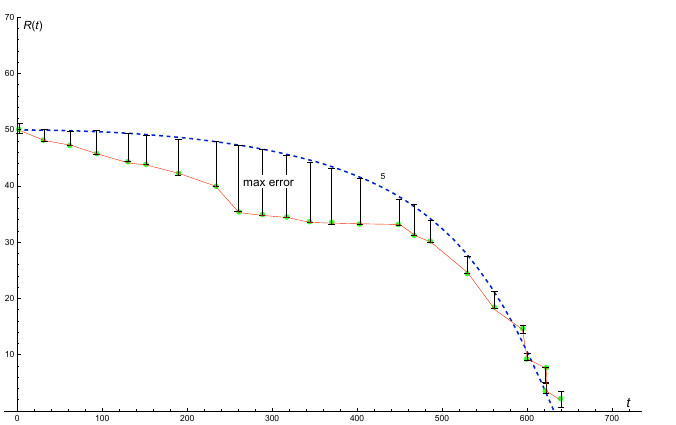
Figure 9. Comparison of results between the solution profile of the mathematical model with the standard protocol and clinical data. The dashed line represents the plot obtained from the mathematical model (see plot number 5 from Figure 7) and the dot plot represents the clinical data obtained from the open access data: https://www.clinicaltrials.gov/, accessed on 25 September 2022. According to our analysis, we obtained that Π 6 = 55.03% and Π 5 = 23.19%. This means that the maximum relative error is between 0 and 55.03 percent for the standard protocol of plot 6 and the maximum relative error is between 0 and 23.19 percent for the standard protocol of plot